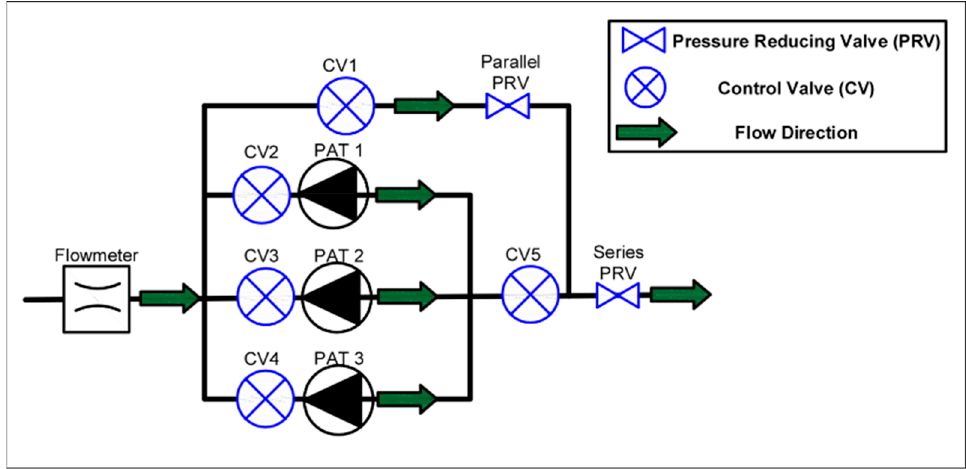
Figure 1. Hydraulic model layout.